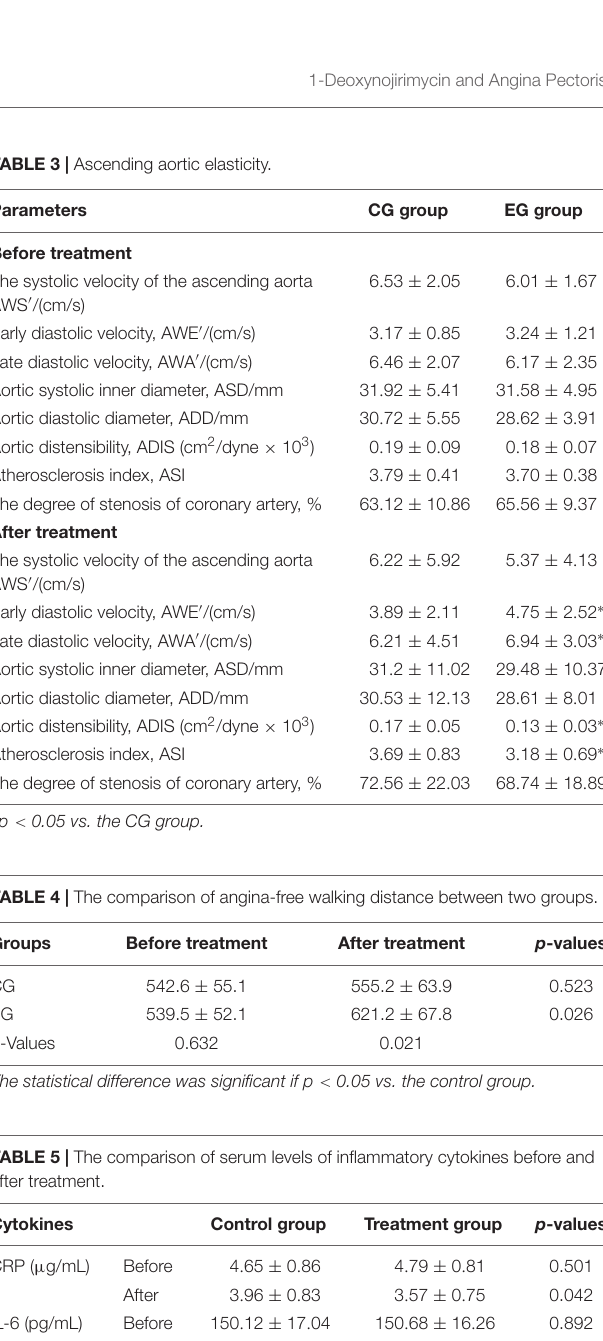
Before the treatment, the statistical difference for the serum levels of SOD ( Figure 2A ) and MAD ( Figure 2B ) was insignificant between the two groups ( p > 0.05). After the 4-week treatment, the serum SOD levels ( Figure 2A ) were increased, whereas the MAD levels ( Figure 2B ) in EG were reduced compared with those in CG ( p < 0.05). The results suggest that DNJ treatment increased the antioxidant capacities of the